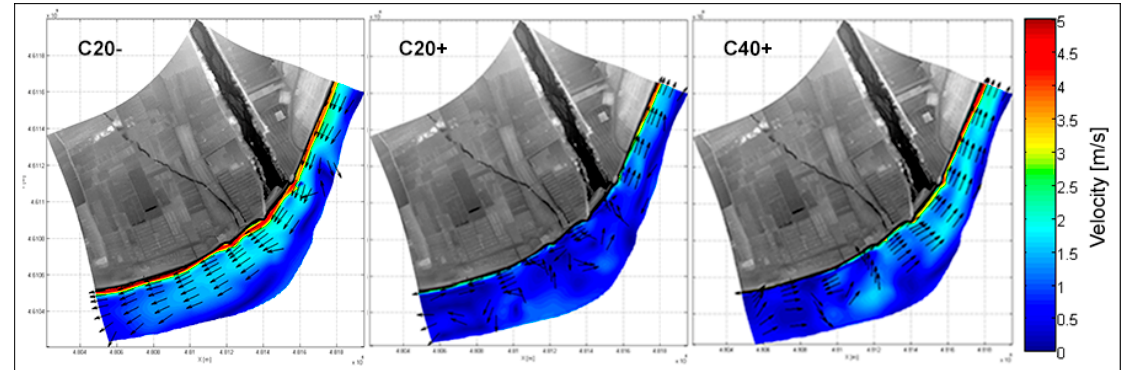
Figure 11. XBeach simulated depth-averaged currents. Mean XBeach output at each 1 h time-step is averaged during the 4 h of maximum storm intensity.